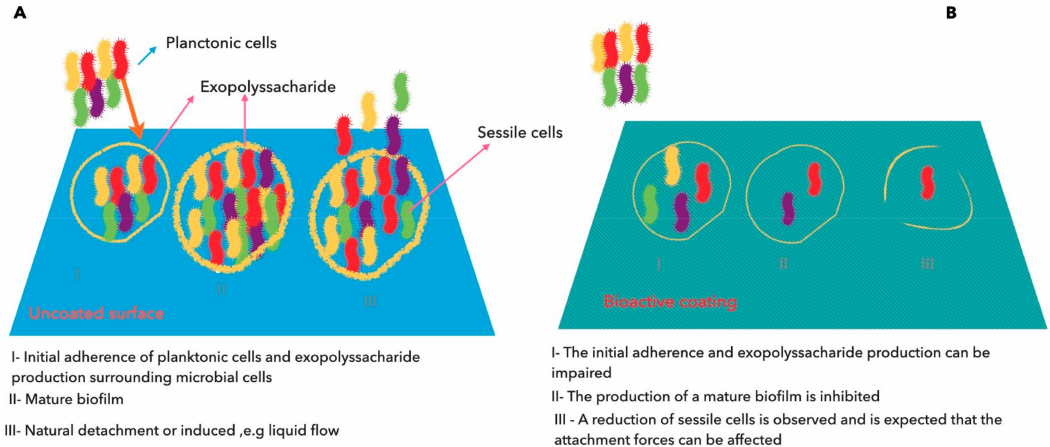
Figure 2. Inhibition of biofilm formation by nanostructured bioactive coating surfaces. ( A ) The uncoated surface allows the adherence of planktonic cells (cells in suspension) with the subsequent production of exopolysaccharides (or glycocalyx) (I) that enclose the sessile cells (adherent cells), forming a mature biofilm (II) and at a later stage can detach from the aggregate and initiate a new cycle of colonization of the same or new surfaces (III). ( B ) A bioactive coating allows the inhibition of the first stage of the biofilm formation: the bacterial adherence and the production of glycocalyx (I). Sessile cells are not able to multiplicate inside the aggregate and the layer of glycocalyx is thinner (II), resulting in a deficient mature biofilm that will collapses